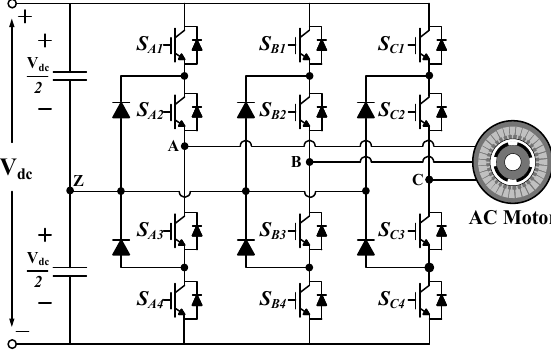
Figure 1. Three-level neutral point clamped (NPC) inverter.